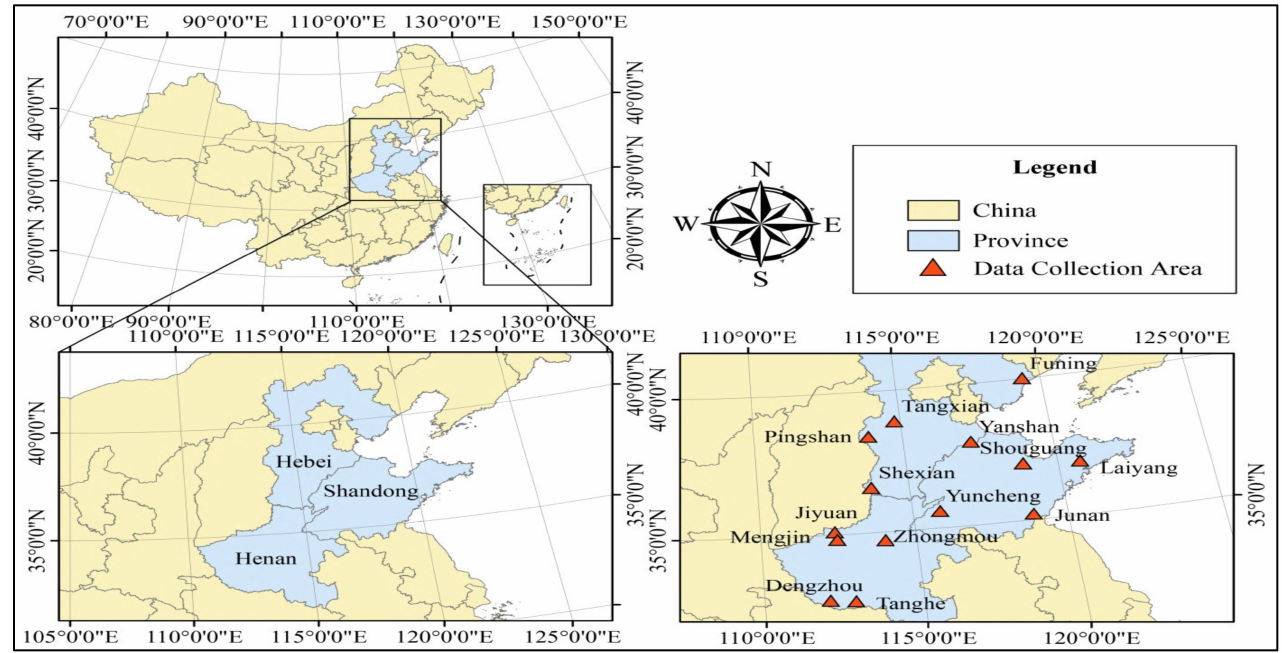
Figure 2. Study area